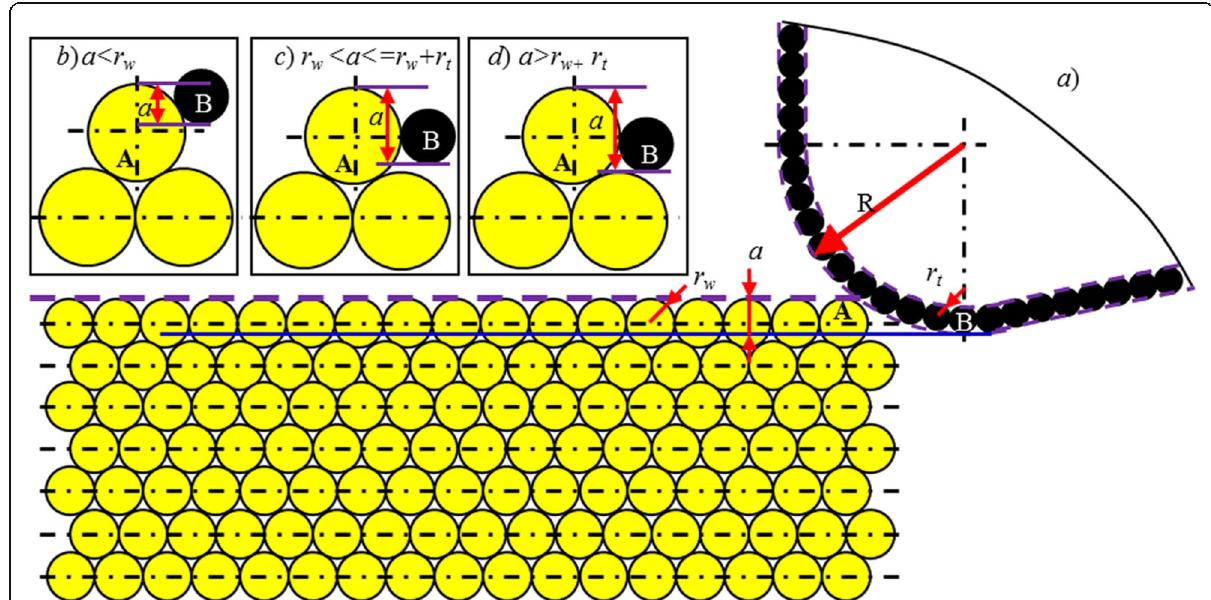
Fig. 14 Schematic diagram for cutting-based single atomic layer removal